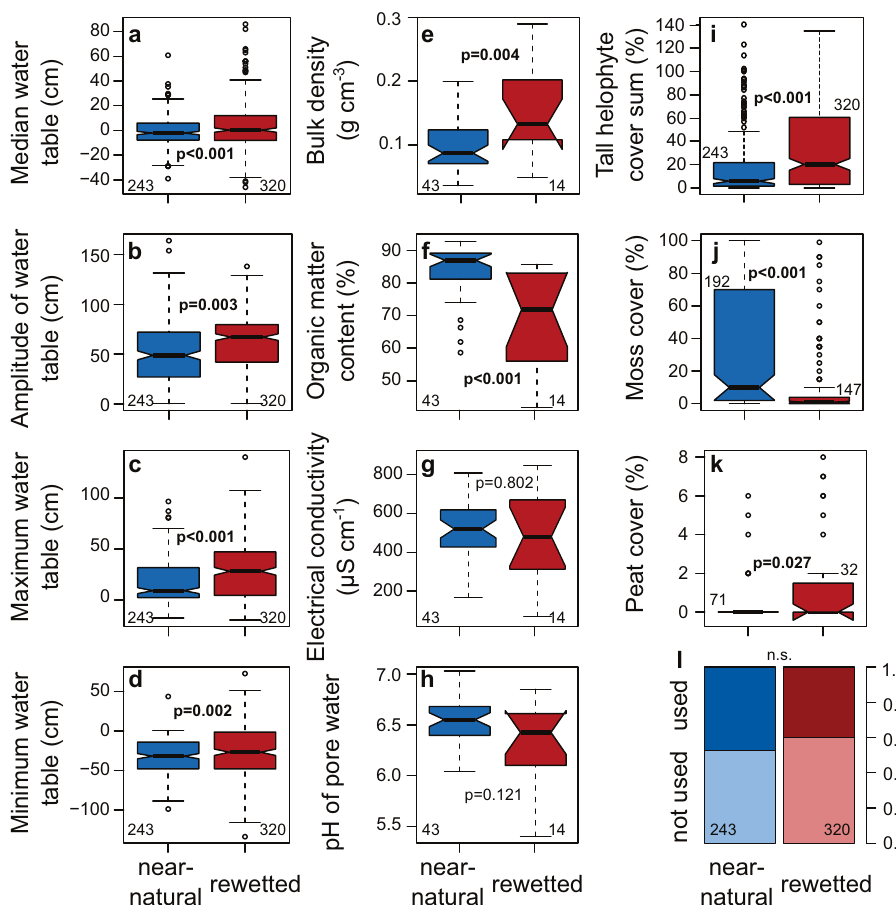
Fig. 3 Rewetted fen peatlands differ in relevant ecological parameters from near-natural fen peatlands. Comparison between rewetted (red) and near- natural (blue) sites for all parameters used in the analyses for hydrology ( a – d ) and for geochemistry ( e – h ) alongside selected other relevant parameters ( i – m ). ‘ Tall helophyte cover sum ’ ( i ) is the sum over all tall helophyte species cover values according to Chytrý et al. 28 . Asterisks indicate signi fi cance of differences according to two-sided Wilcoxon-rank test for numerical and Chi² test for factorial response parameters (*** p < 0.001; ** p < 0.01; * p < 0.05). n per group is provided as numbers next to the boxplots, n differs between parameters as data was not available for all sites and all parameters, respectively. The boxplots display the median, quartiles (box), 1.5-fold quartile distance (whiskers) and extremes beyond the which led to a mean annual water table of 25cm below surface or higher. Rewetting occurred on average 9 years (min. 1 and max. 54 years) before data sampling. Land use before rewetting was agriculture (80% of all rewetted sites), forestry (10%) or peat extraction (10%). We acknowledge that few, if any, untouched and completely natural temperate fens exist nowadays in Europe. For our comparison, we used sites without direct drainage history, again relying on local expert knowledge. We